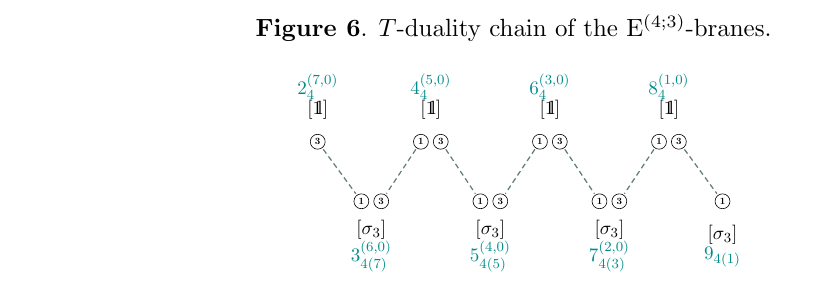
Figure 7 . T -duality chain of the E (4;0) -branes.